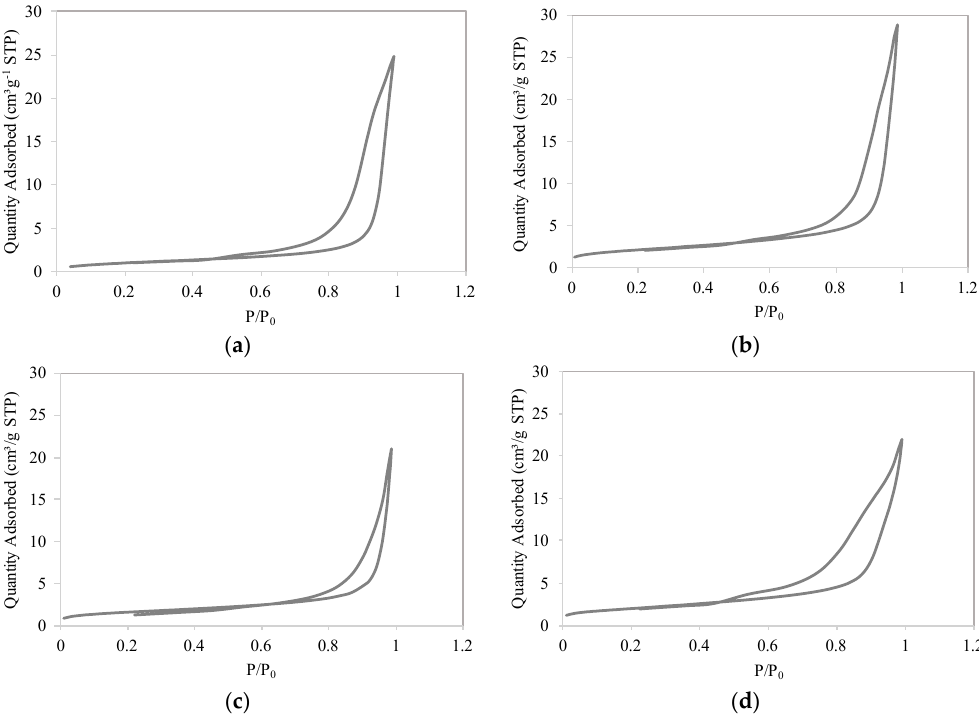
Figure 5. Adsorption isotherms for nanoplates synthesized ( a ) without using surfactant and using CTAB with different precursor:surfactant:solvent ratios ( b ) 1:1.6:740; ( c ) 1:3.2:740; ( d ) 1:4.8:740, no surfactant.